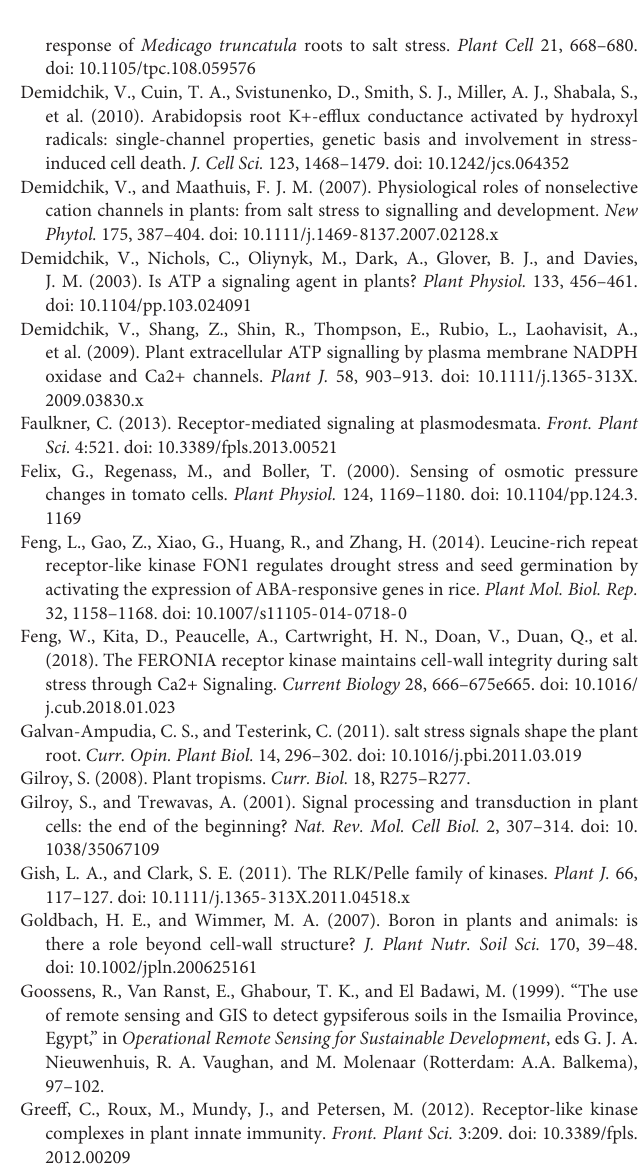
Supplementary Figure 2 | Bioinformatic analysis of GRP14 as a candidate ionic sensor by TMHMM, ProtParam, and AlphaFold. (A) Analysis of the extracellular, transmembrane, and intracellular domains of GRP14. (B) 3D domain analysis of GRP14. (C) Analysis of the amino acid charge properties of the extracellular domain of GRP14. The online tools TMHMM Server v. 2.0 (http://www.cbs.dtu.dk/ services/TMHMM/), Expasy ProtParam (https://web.expasy.org/protparam/), and AlphaFold Protein Structure Database (https://alphafold.ebi.ac.uk/) were used for the analysis. Supplementary Table 1 | The protein sequences of some possible sensors or receptors in Arabidopsis thaliana analyzed by